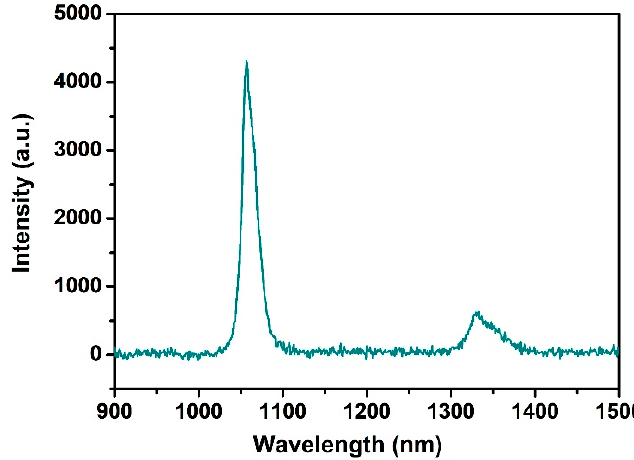
Figure 4. The NIR emission of compound 1 excited at 808 nm by laser.